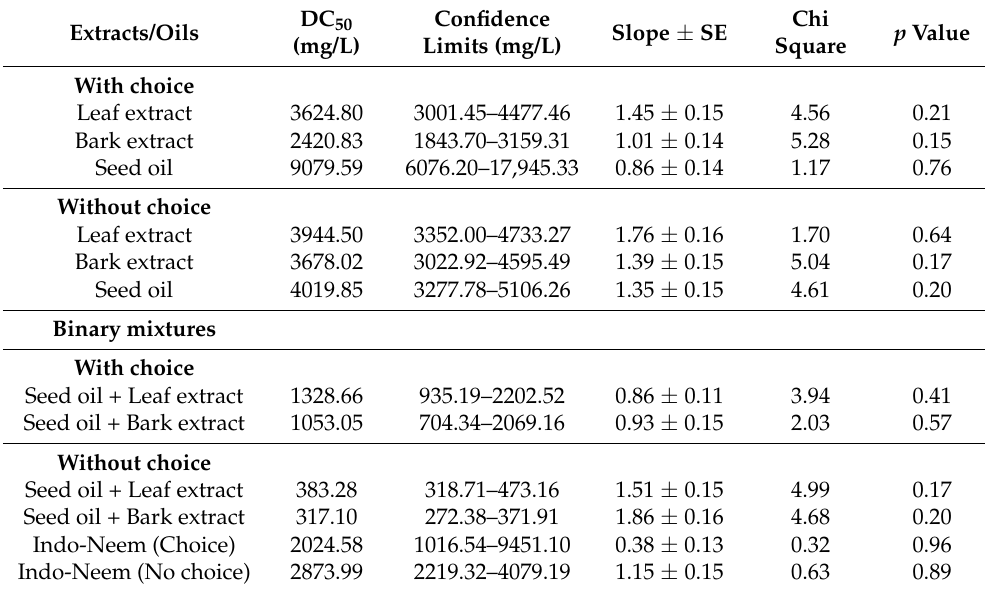
Table 2. Feeding deterrence of leaf, bark ethanol aqueous extracts, and seed oil of Triadica sebifera against Plutella xylostella .